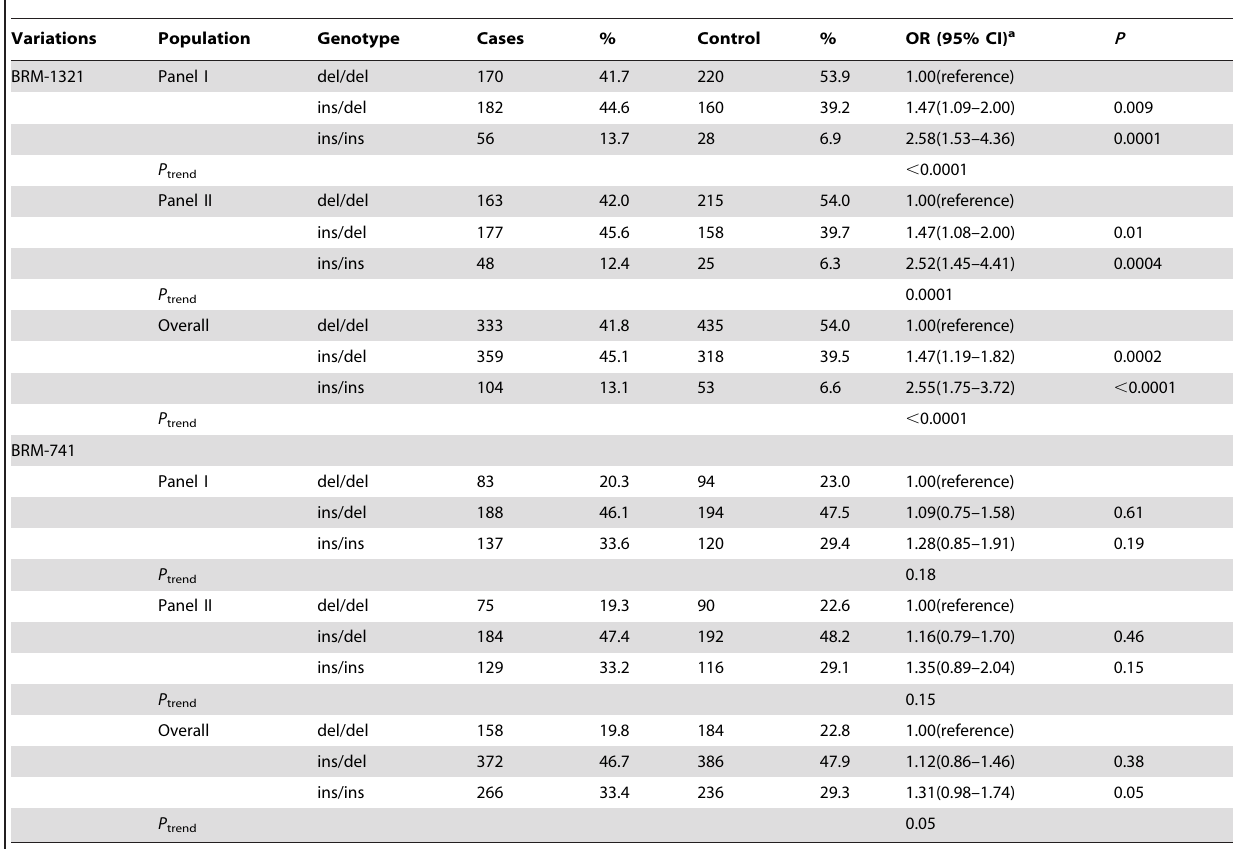
Table 2. Associations between BRM promoter Indel genotypes and HCC